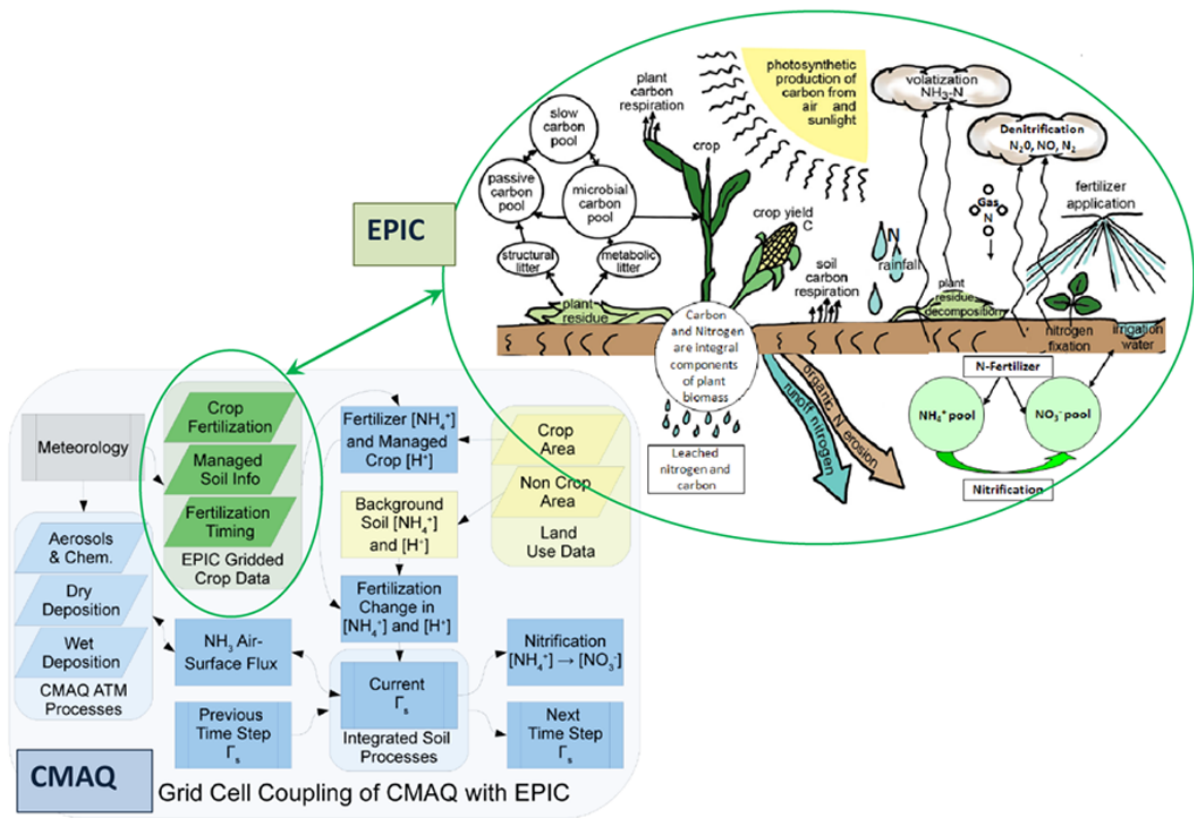
Fig. 8. Example of coupled CTM (CMAQ) and crop (EPIC) models for NH 3 exchange, modified from Cooter et al. (2012). Top: Biogeo- chemical components of the carbon and nitrogen budgets in EPIC; bottom: flow chart of EPIC coupled with CMAQ bi-directional NH 3 exchange. Arrows represent the flow of information, meteorological processes are shown in grey, EPIC processes in green, land use and land use-derived data in tan, and CMAQ processes in